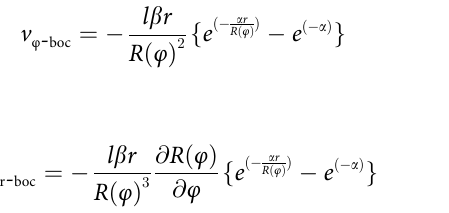
where v is the velocity in the horizontal direction; v x Region boc :